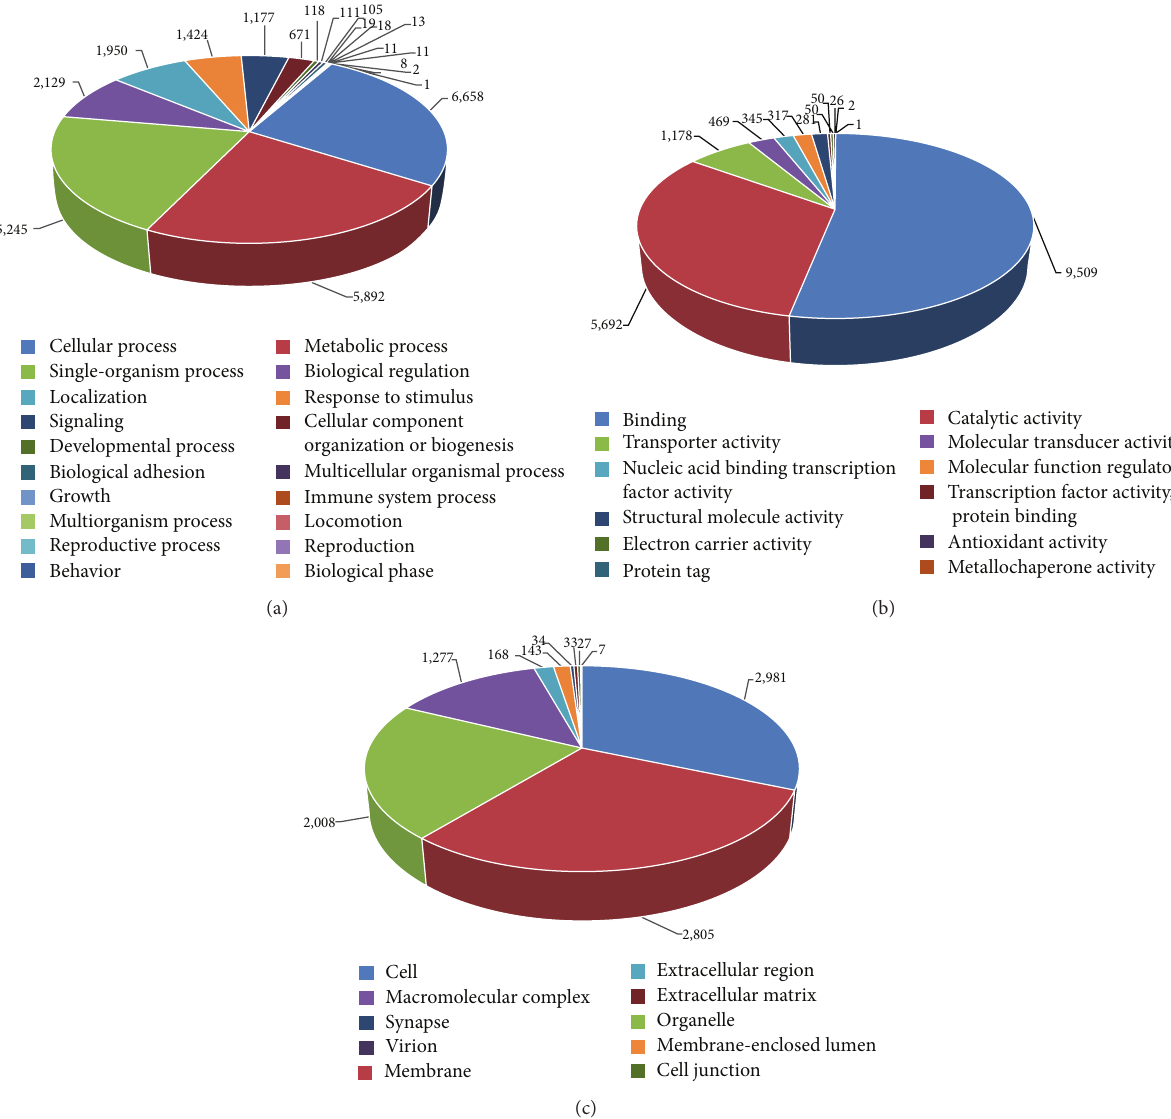
Figure 6: Gene Ontology classifications of assembled unigenes from V. mandarinia . (a) Biological processes, (b) molecular function, and (c) cellular components. The number of unigenes ascribed to each subcategory for each classification has been